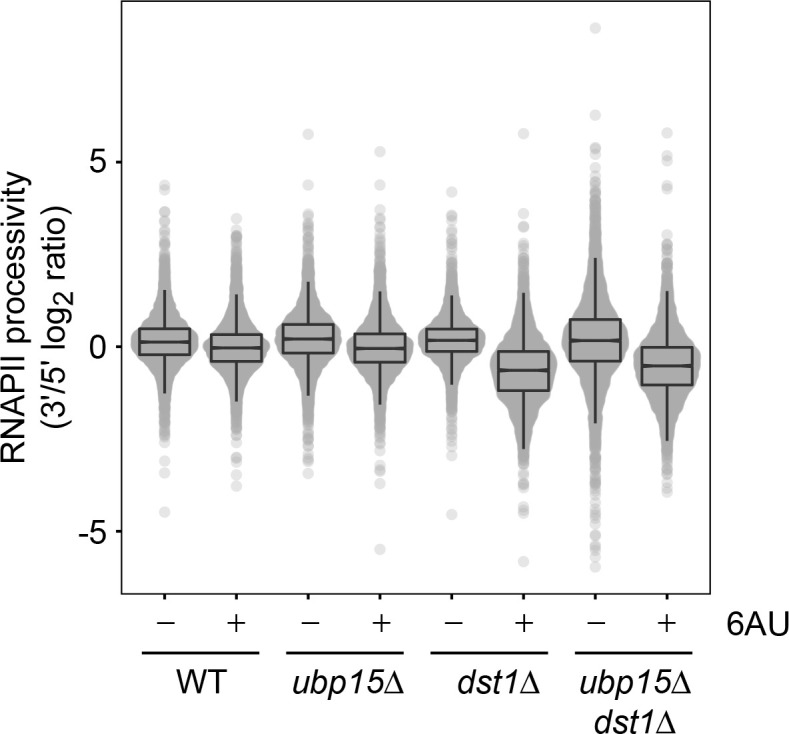
Violin plot showing the RNAPII processivity, as determined by the log2 ratio of RNAPII (Rpb3) occupancy in the last 300 bp versus the first 300 bp of each gene, as determined by ChIP-chip.All genes with measurable values are shown (n = 4889).